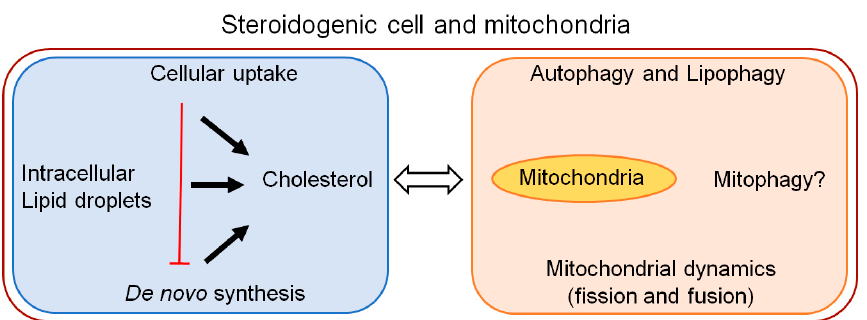
Figure 2. Schematic diagram depicting known and potential relationship between cholesterol homeostasis and mitochondrial attributes in major steroidogenic cells. The interplay between different intrinsic factor expected to vary under basal, acute and chronic steroidogenic state (as applicable) because of a wide range of different steroid hormone levels and their physiological need.